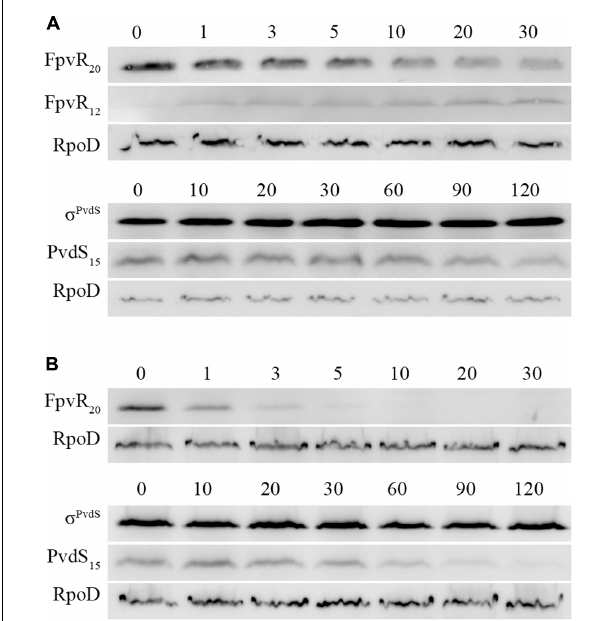
FIGURE 5 | Effects of clpP mutation on degradation of FpvR 20 and σ PvdS . Pyoverdine was added (0 min) to P. aeruginosa PAO1 pvdF bacteria containing a mutation in the clpP gene. Samples were collected at intervals and analyzed by Western blotting. Times are shown in minutes. (A) P. aeruginosa PAO1 pvdF clpP . (B) P. aeruginosa PAO1 pvdF clpP (minictx:: tig-clpP ). FpvR 20 , FpvR 12 , σ PvdS (full-size), PvdS 15 and RpoD are indicated. FpvR 12 was not detected in P. aeruginosa PAO1 pvdF clpP (minictx:: tig-clpP ). Similar results were obtained when the experiment was repeated (Supplementary Figure S4).